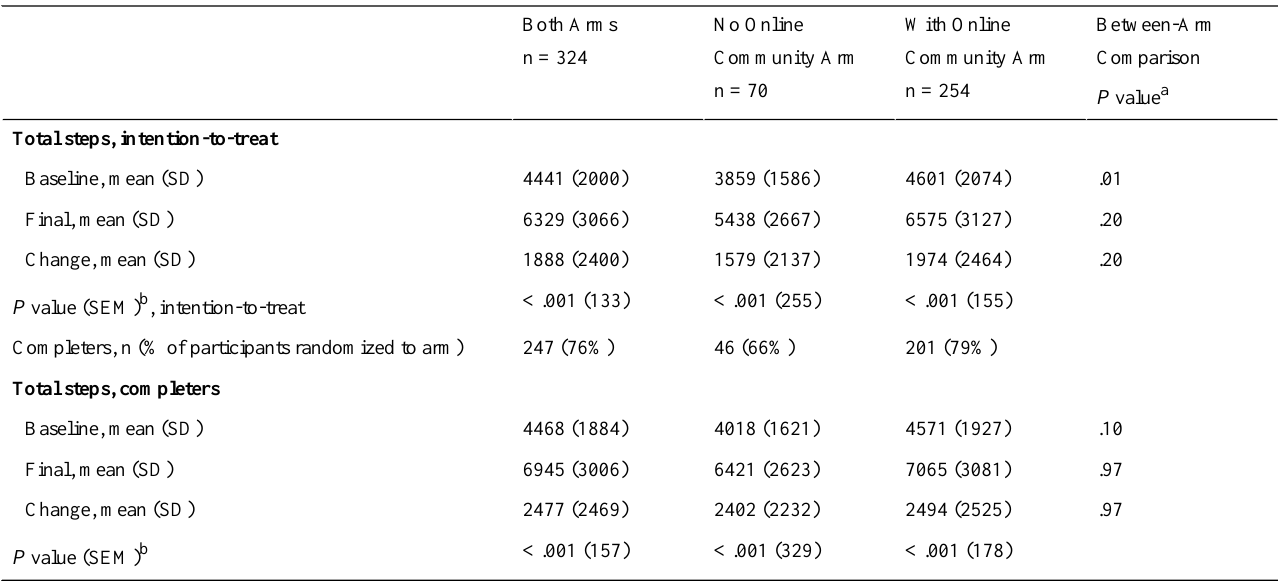
Figure 4 for average step-count change by week. The rate of increase in step counts did not differ by arm ( P =